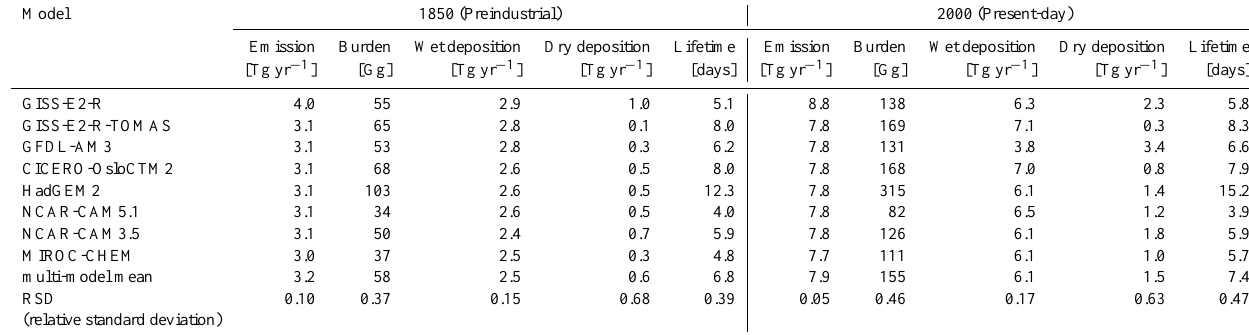
Table 3. Global average BC budgets in 1850 and 2000 including emission, wet and dry deposition, burden, and lifetime.